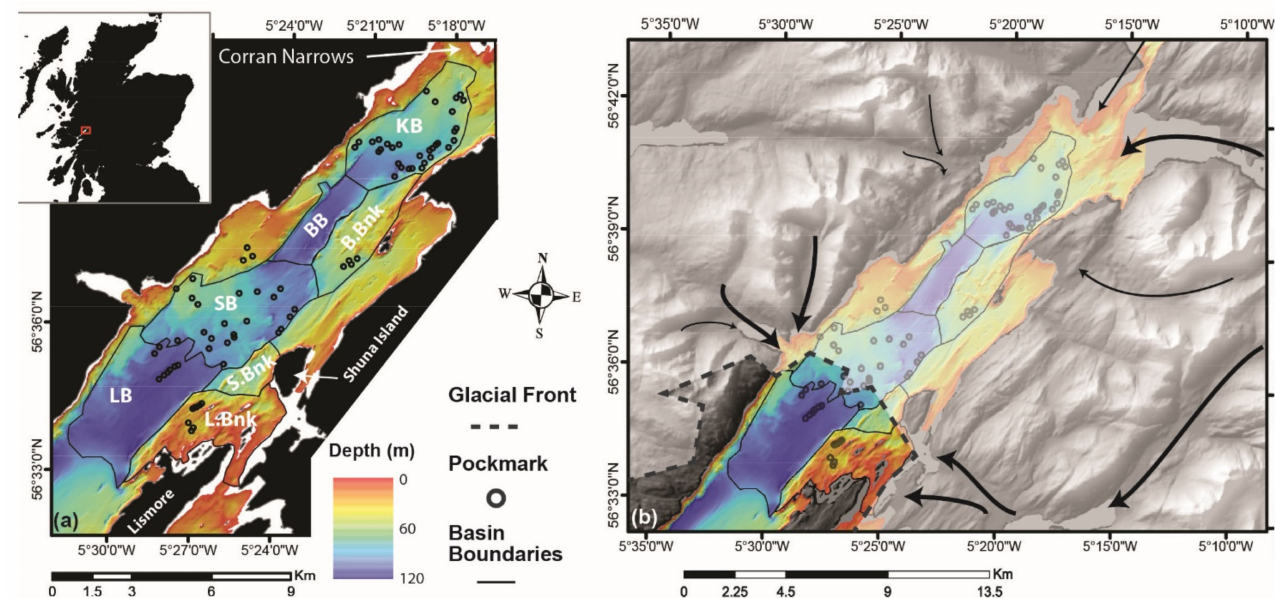
Figure 1. Maps of Loch Linnhe; ( a ) bathymetry of Loch Linnhe, location of pockmarks and basins; KB—Kentallen Basin, BB—Balnagowan Basin, B.Bnk—Balnagowan Bank, SB—Shuna Basin, S.Bnk—Shuna Bank, LB—Lismore Basin, L.Bnk— Lismore Bank; ( b ) map of the glacial ice cover during the Younger Dryas based on the model by [33]. Arrows show the main glacial flow from Rannoch Moor (west) and tributary glaciers from the